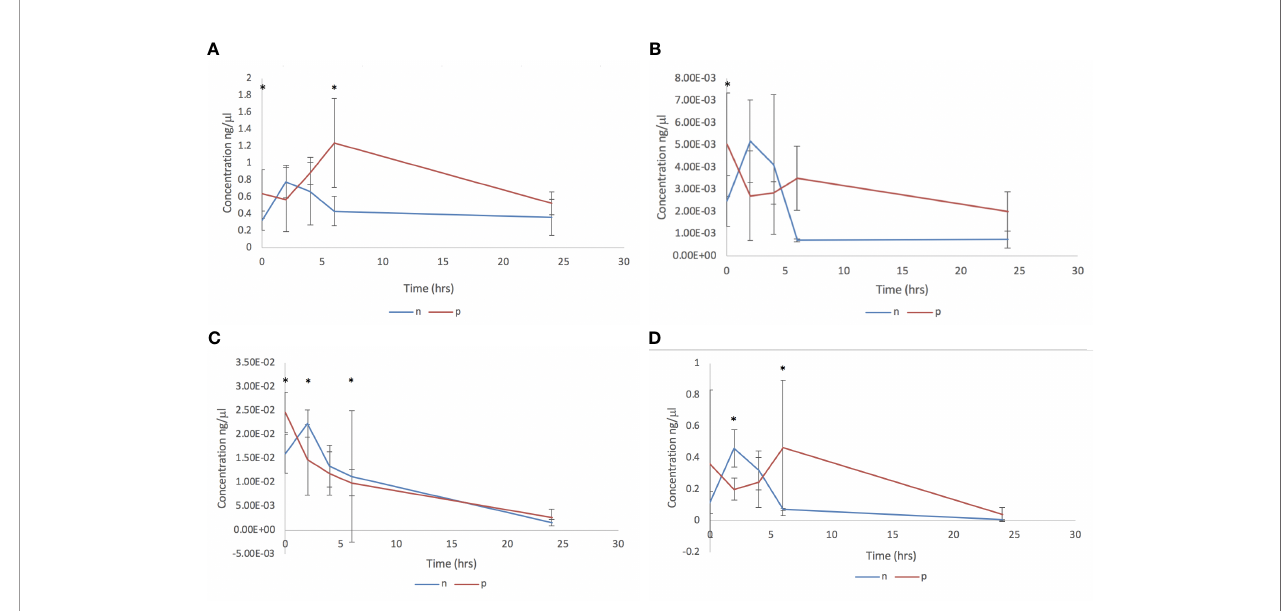
FIGURE 3 | Bacterial qPCR analysis following in vitro culture of rumen fl uid incubated with C. daubneyi SEC puri fi ed EVs (p) and without EVs (n). Data shown for (A) Total bacteria, (B) Fibrobacter succinogenes , (C) Ruminococcus albus and (D) Prevotella spp. *indicates a signi fi cant difference between treatment